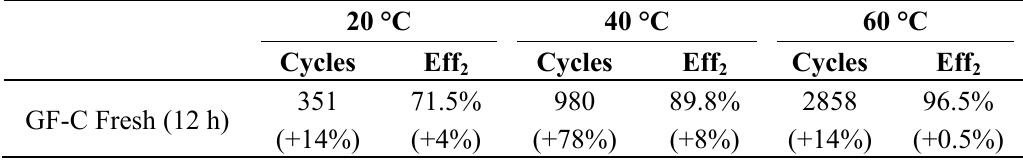
Table 2. Number of cycles before the cut-off voltage is reached and corresponding efficiencies, according to Equation (3) ( Q TFSI-0.1 LiTFSI/Li cell including a GF-C of Li/0.9 Pyr 14